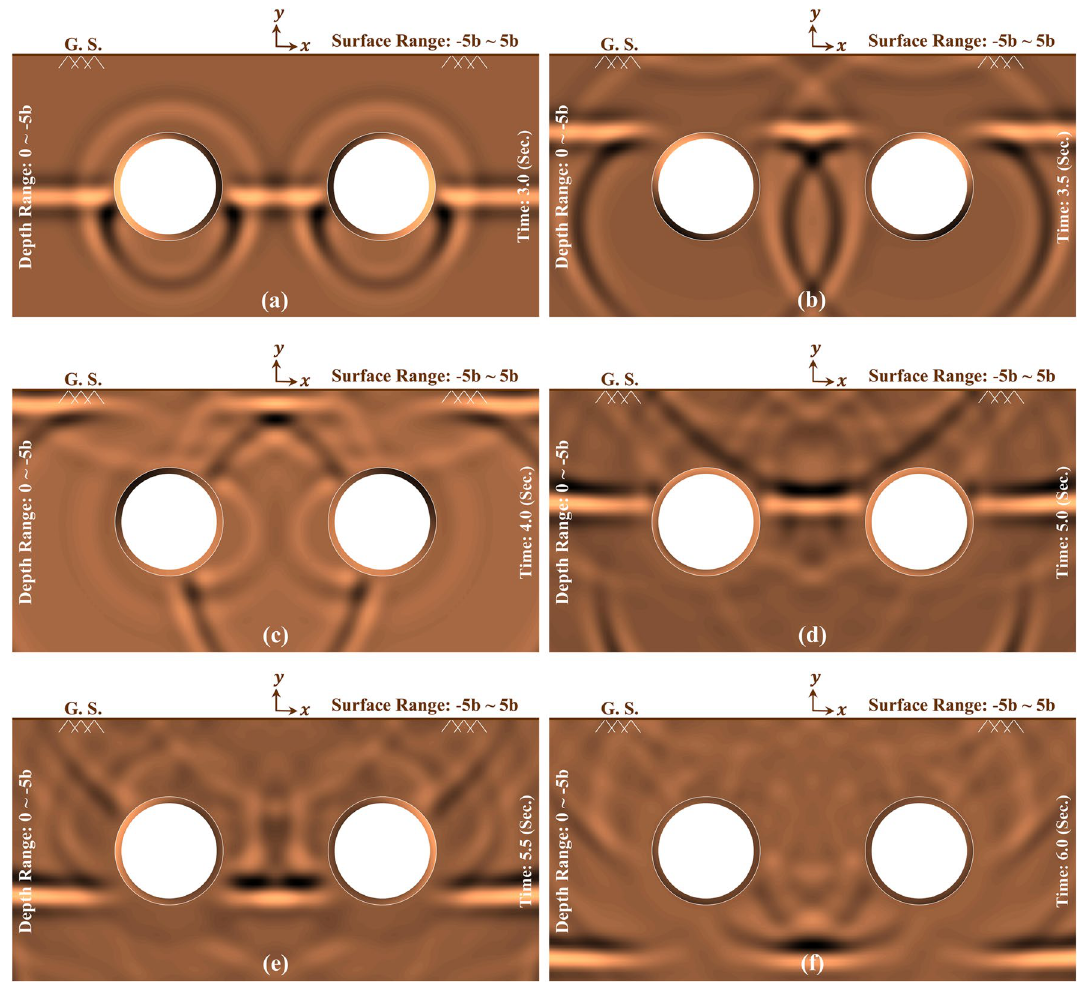
Fig. 5 Wave propagation snapshots and the procedure of the SH waves’ dispersion below the ground surface, for the model of twin circular- shaped lined tunnels subjected to vertical incident